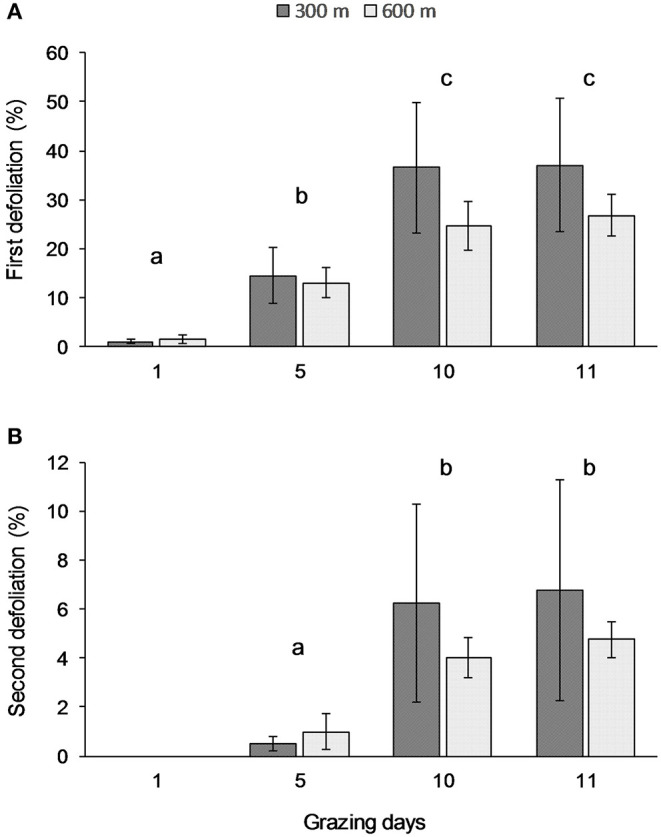
Average percentages of plants defoliated for the first (A) and the second (B) time at grazing days 1, 5, 10, and 11, respectively at 300 and 600 m from water sources. Error bars represent Standard Error of the Means. Lowercase letters indicate significant differences among days of grazing (A: p < 0.001; B: p < 0.01).